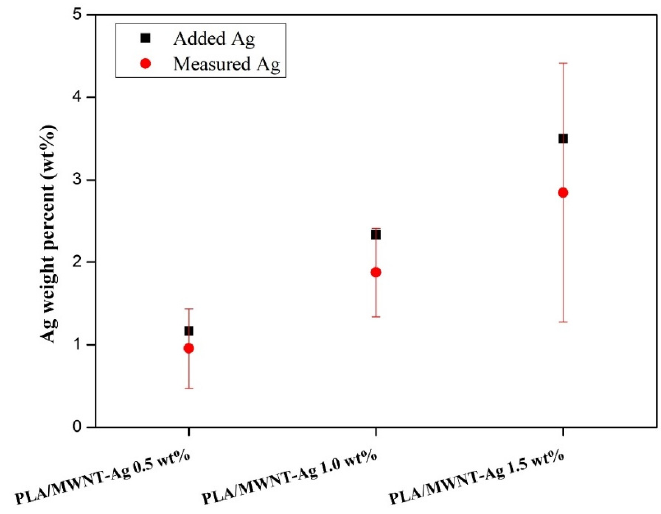
Figure 6. EPMA quantitative analysis of PLA/MWNT-Ag films.